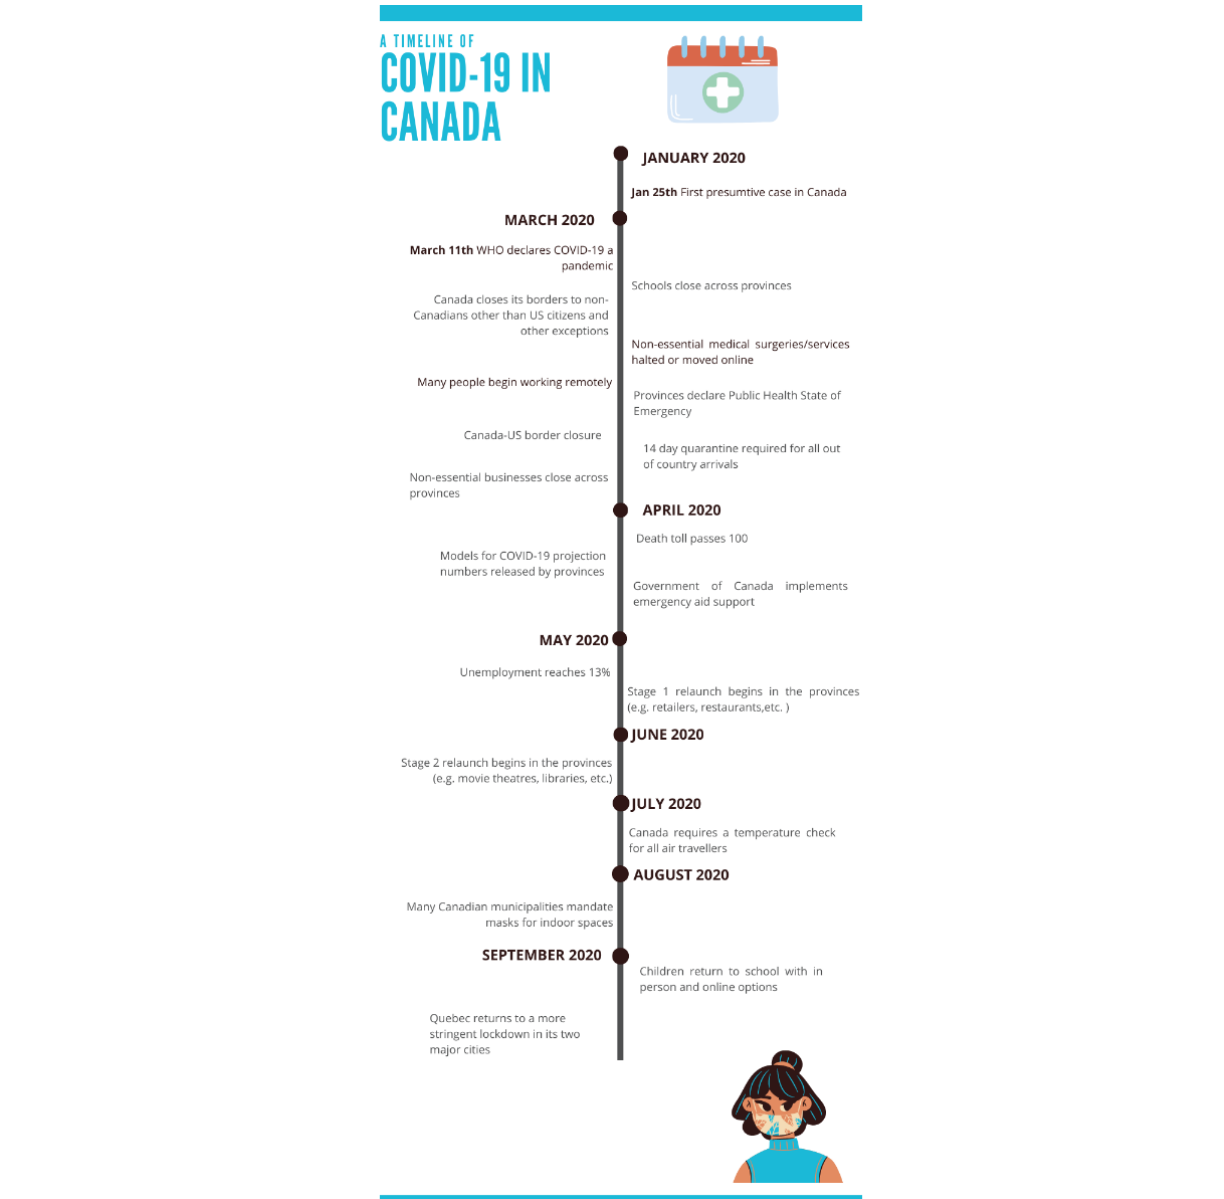
Figure 1. Timeline of COVID-19